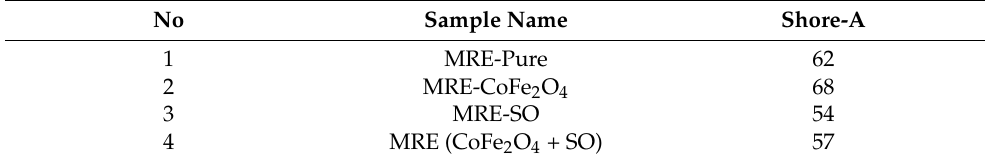
Table 2. MRE samples with additive